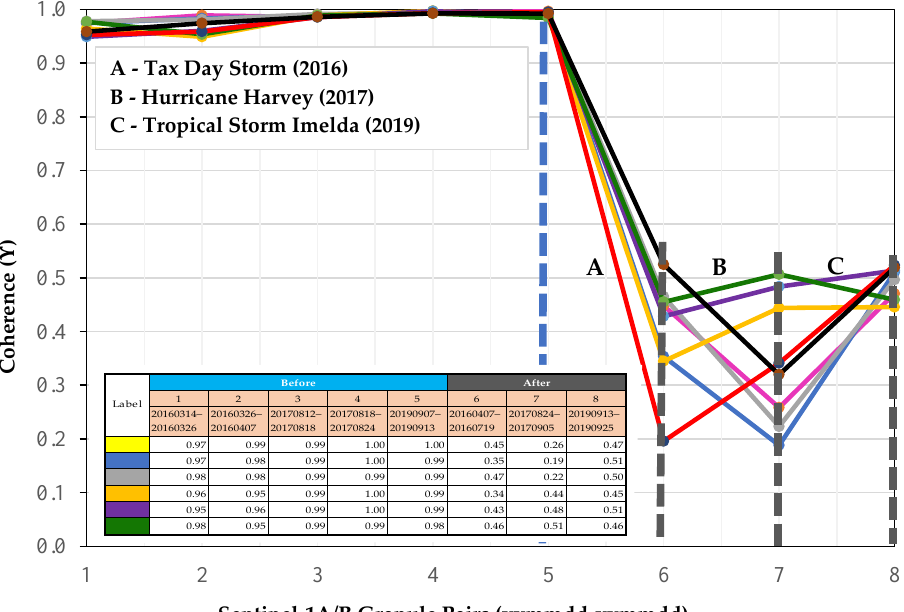
Figure 5. Changes in the coherence values of the pixels in the George Bush Intercontinental Airport area (for location, see Figure 4). With few exceptions, Hurricane Harvey seems to have inflicted significant surface changes in the area, as revealed by the higher percentage of decline in coherence values (64.64%), followed by the Tax Day storm (58.96%) and then Tropical Storm Imelda